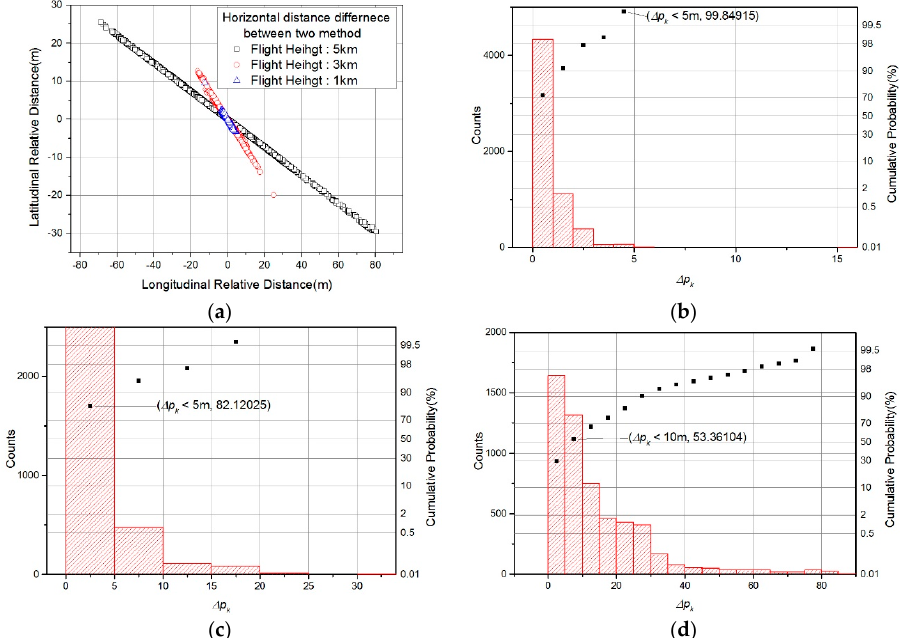
Figure 16. Horizontal position difference between closest points obtained using conventional method and proposed method: ( a ) horizontal graph; ( b ) histogram and cumulative probability at flight altitudes of 1 km; ( c ) 3 km; ( d ) 5 km.